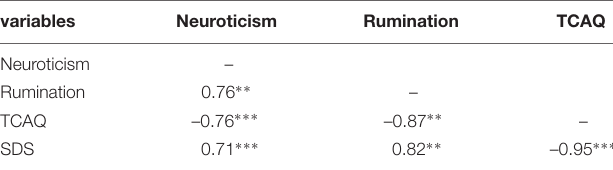
TABLE 6 | Correlations matrix in MDD.